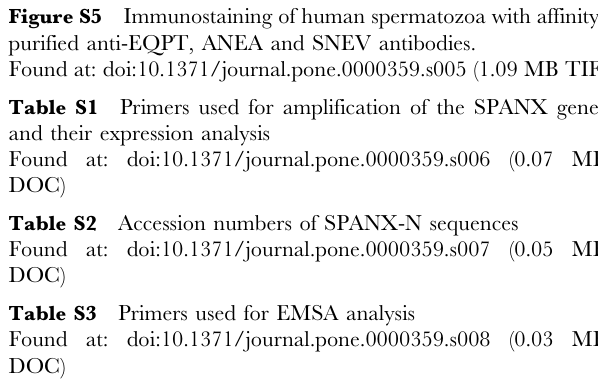
Figure S1 Alignment of primate SPANX-N proteins. The chimpanzee SPANX-N3 contains 4 minisatellite repeats in frame. The chimpanzee SPANX-N2 contains 2 minisatellite units while human SPANX-N2 contains seven 39 bp units. The chimpanzee Figure S2 Phylogenetic relationship of SPANX-N proteins in primates. The tree topology was obtained using PHYML v2.4.4 using default parameters and 100 replicates. Figure S3 RT-PCR analysis of the canine SPANX-N expres- tides designed within exons 1 and 2 to amplify a putative